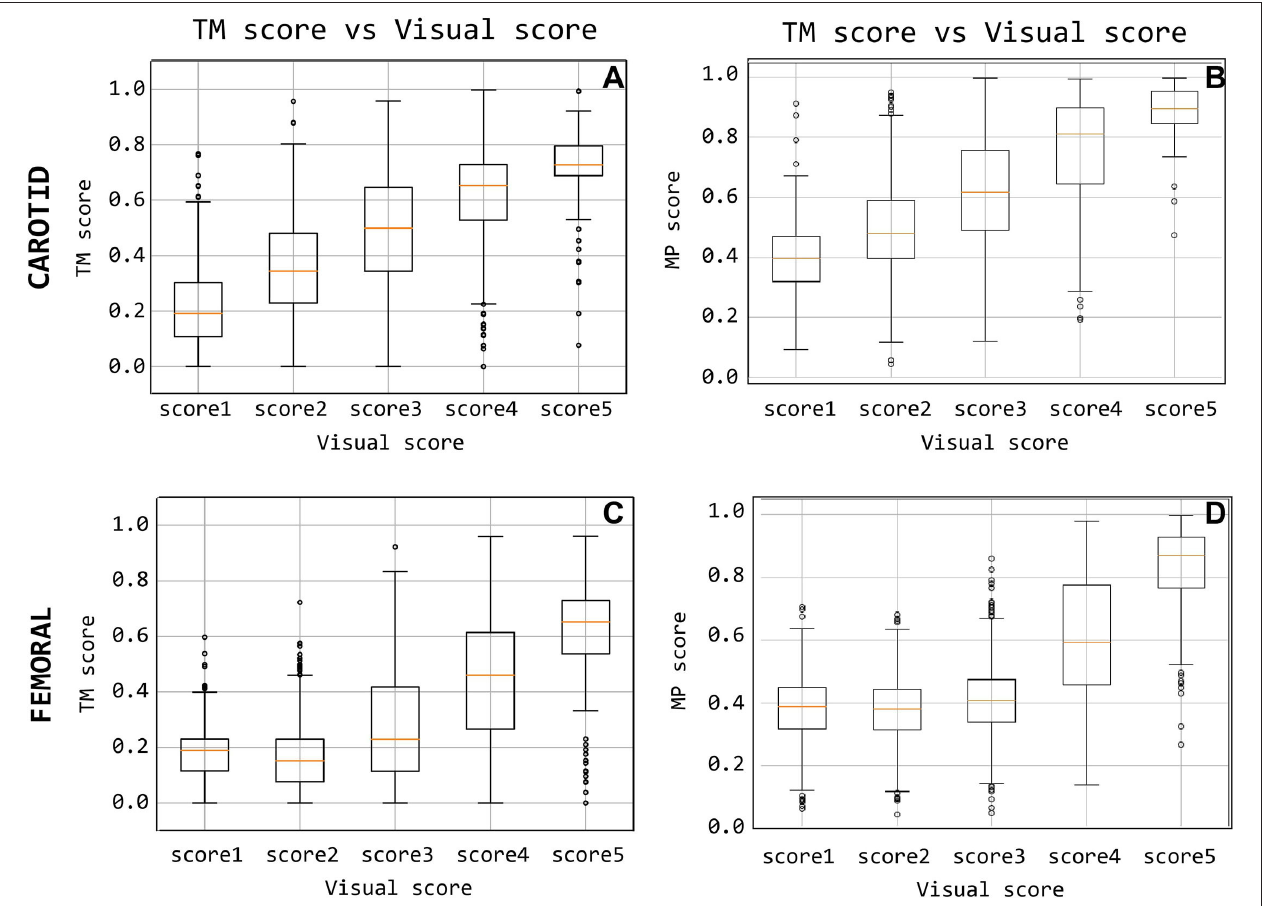
FIGURE 10 | Quality score comparison between visual score and the template-matching-derived and matrix-profile-derived. Subfigures (A,C) display the score based on the template matching and (B,D) quality score based on the matrix profile.